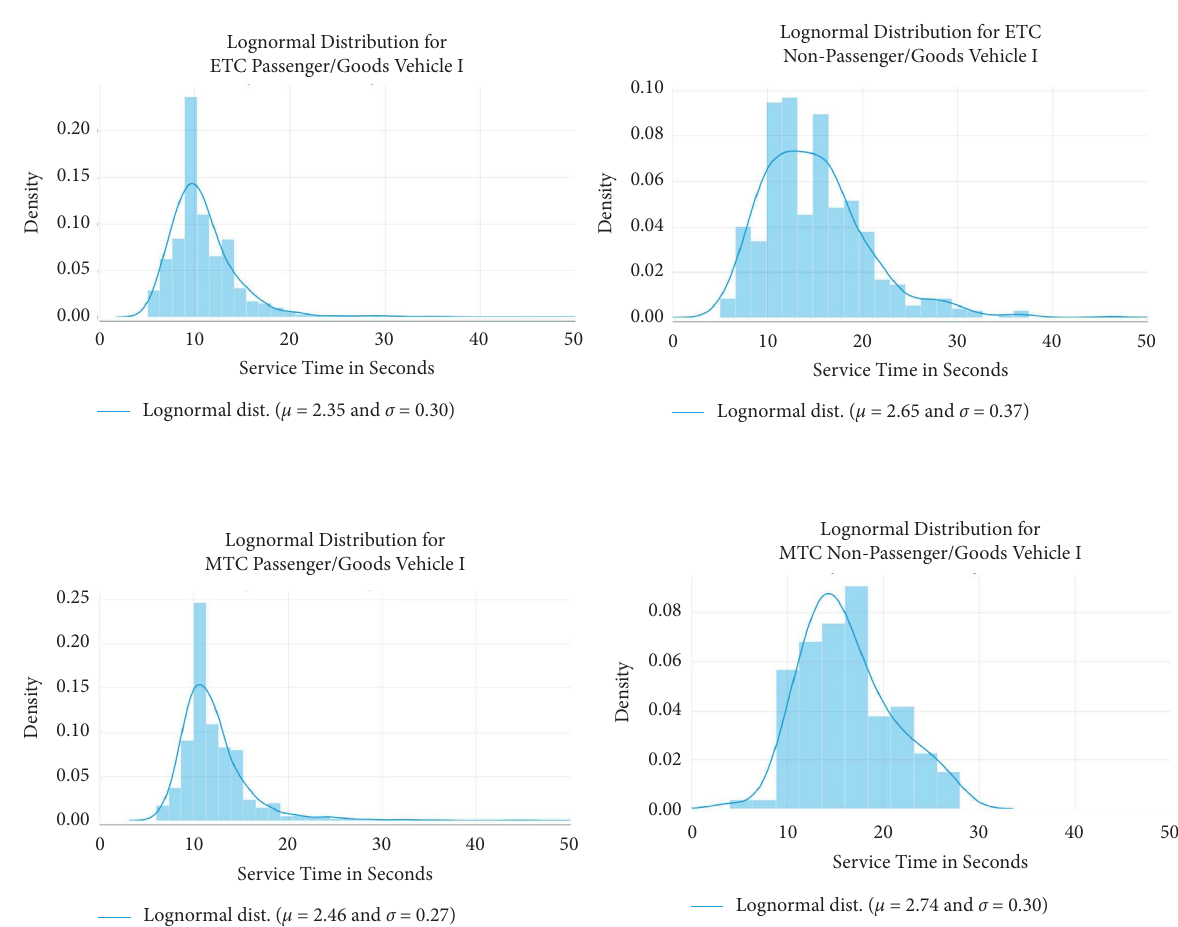
Figure 8: Lognormal distribution for diferent vehicle classes of lane 15# .